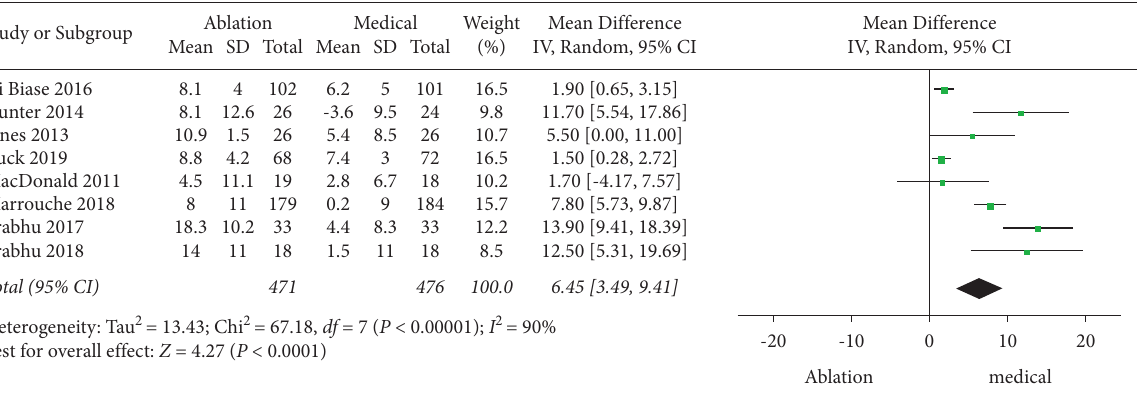
Figure 4: Forest plot of CA versus medical therapy: LVEF.